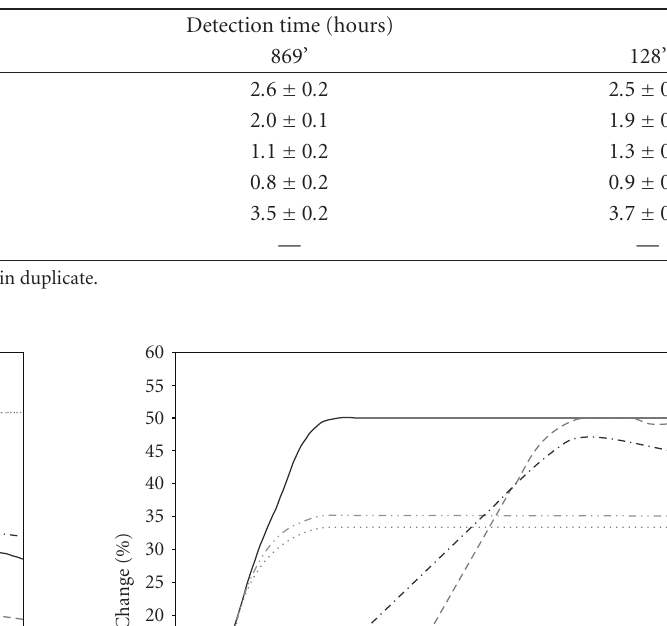
Table 2: E ff ect of cell concentration on the detection times.